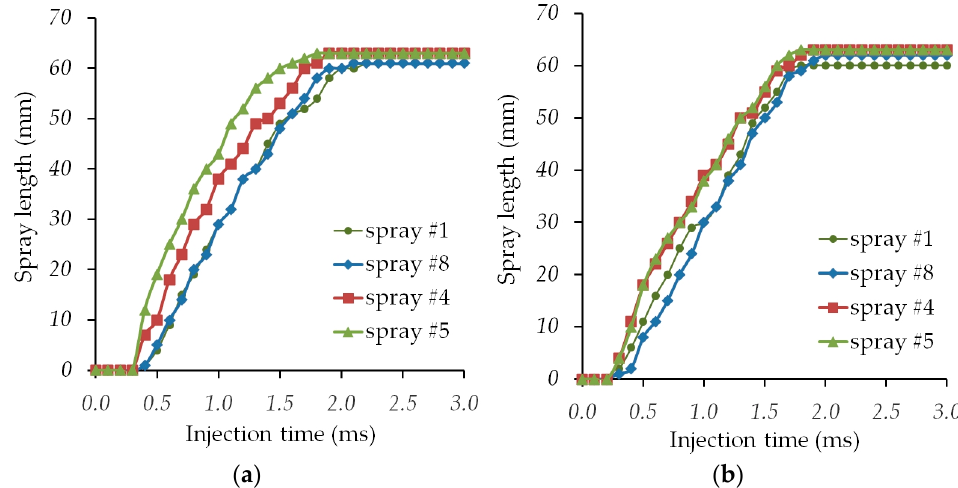
Figure 11. Dynamics of change in the length of the fuel sprays 1, 8 and 4, 5 for the nozzle 1 ( a ) and the nozzle 2 ( b ) with a rail pressure of 165 MPa.